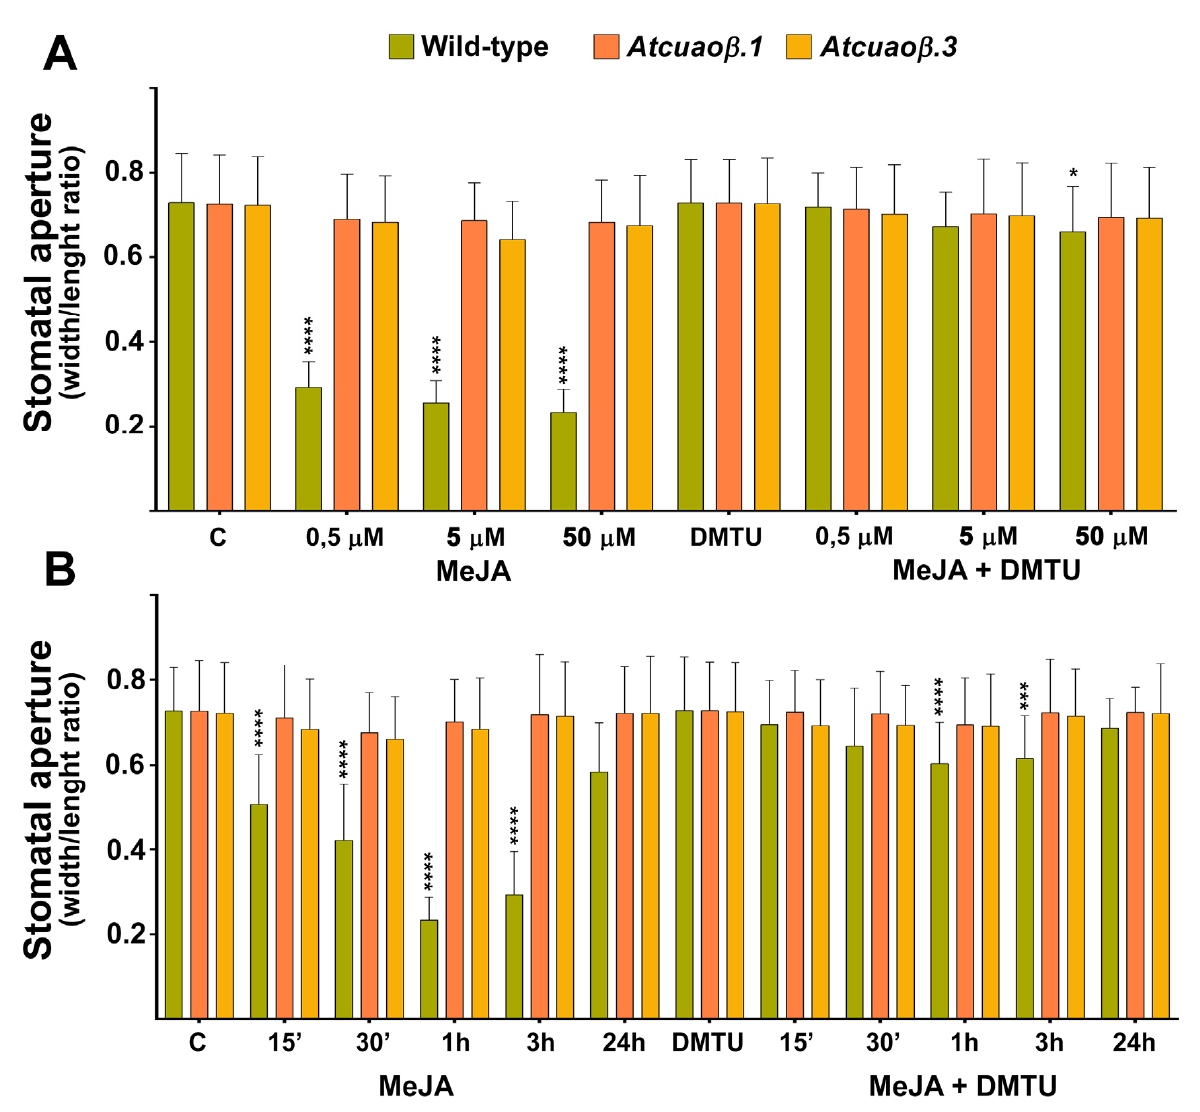
Figure 4. Effect of three different concentrations of MeJA and N,N ′ -dimethylthiourea (DMTU) ( A ) and time course analysis of the effect of MeJA and DMTU ( B ) on stomatal pore width/length ratio of seven-day-old WT, Atcuao β .1 and Atcuao β .3 mutant seedlings. Seedlings were treated for 1 h with 0.5, 5, or 50 µ M MeJA and 100 µ M DMTU, either alone or in combination with each hormone concentration ( A ). Seedlings were treated for 15, 30 min, 1, 3 and 24 h with 50 µ M MeJA and 100 µ M DMTU, either alone or in combination with the hormone ( B ). Mean values ± SD ( n = 15) are reported. The significance levels between WT control plants and WT treated plants are reported. p levels have been calculated with one-way ANOVA analysis; p levels > 0.05; *, ***, and **** p levels are equal to or less than 0.05, 0.001 and 0.0001, respectively.